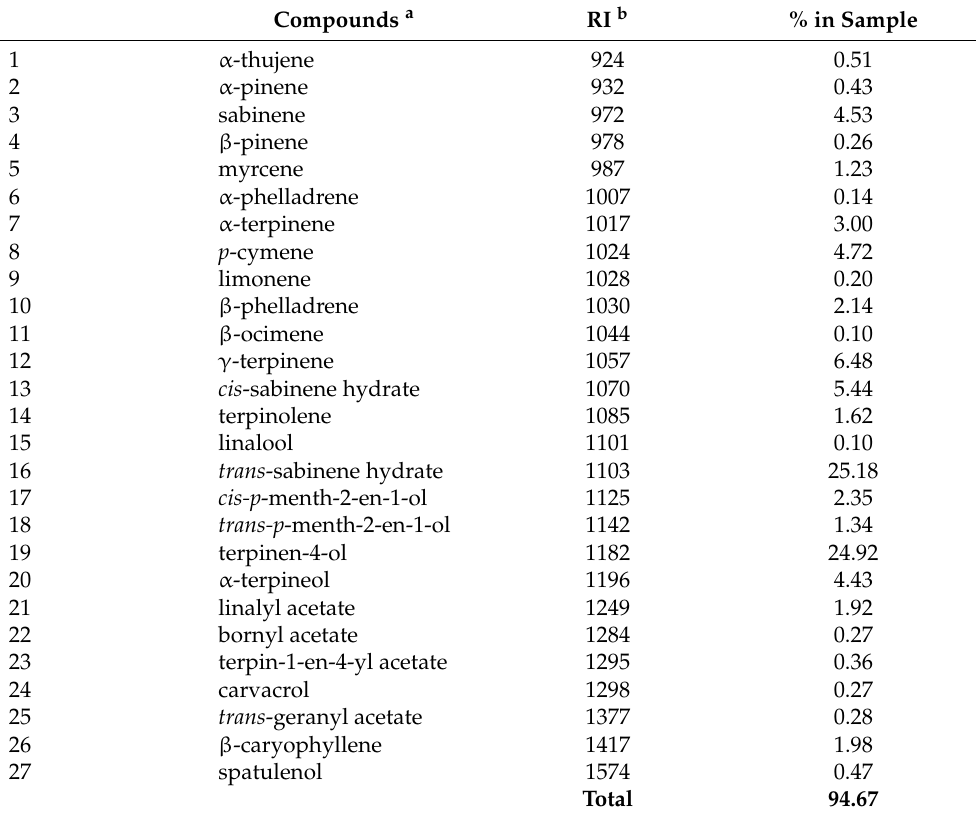
Table 1. Chemical composition of essential oil of Hungarian variety of O. majorana